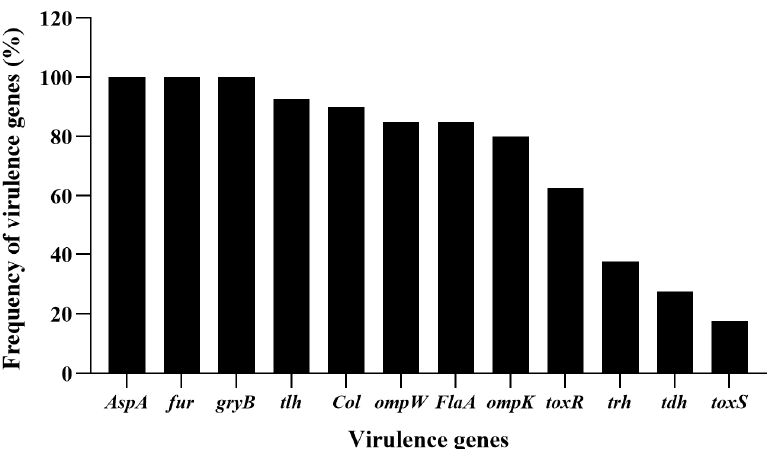
Figure 1. Frequency of virulent genes detected in the isolates of V. alginolyticus . Twelve virulent genes, Col , AspA , tlh , tdh , trh , FlaA , ompK , ompW , fur , gyrB , toxR and toxS were selected for PCR detection for the V. alginolyticus isolates.